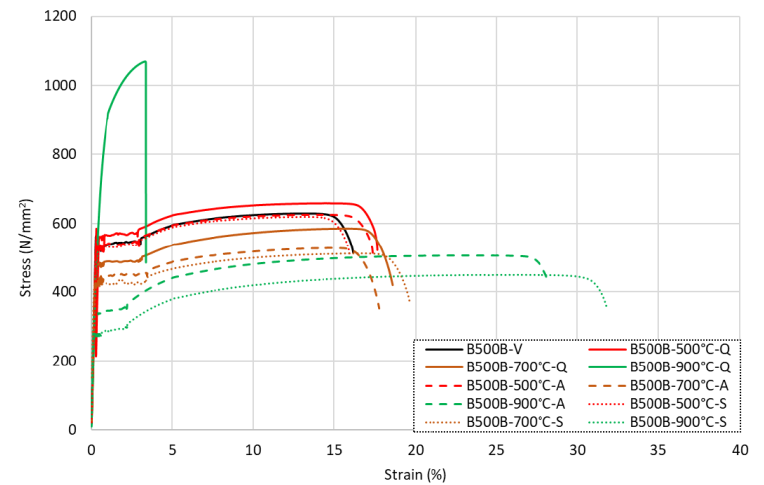
Figure 11. Stress – strain response for grade B500B carbon steel rebars following exposure to 500 °C, Figure 11. Stress–strain response for grade B500B carbon steel rebars following exposure to 500 ◦ C, 700 °C, and 900 °C, followed by cooling. 700 ◦ C, and 900 ◦ C, followed by